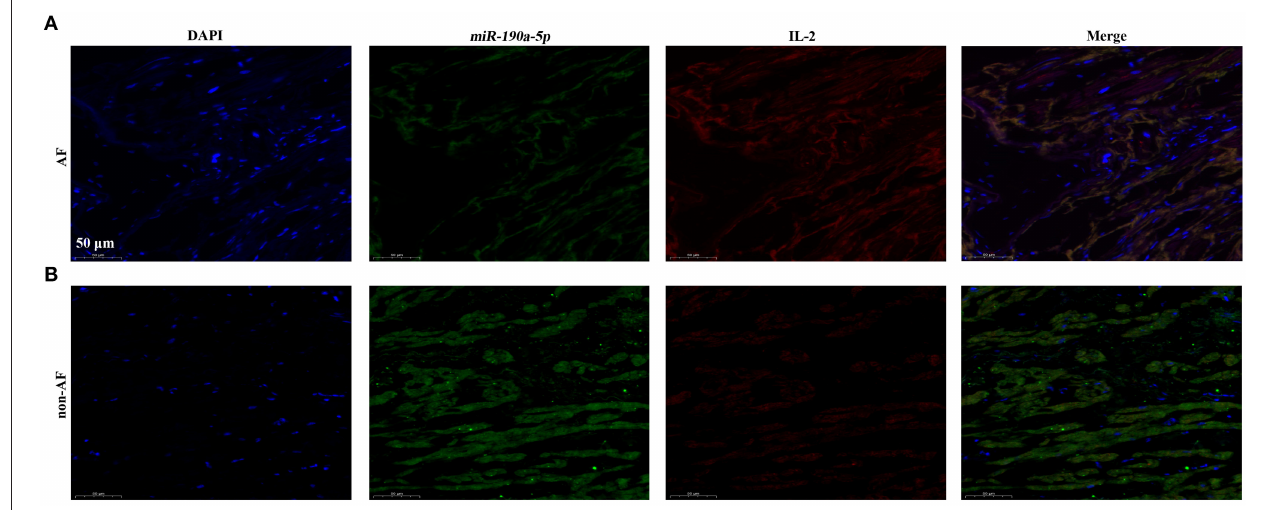
FIGURE 3 | In cardiac tissues of patients with AF, miR-190a-5p was downregulated while IL-2 was upregulated. (A) Immunofluorescence co-staining of miR-190a-5p and IL-2 in human cardiac tissues of patients with AF. (B) Immunofluorescence co-staining of miR-190a-5p and IL-2 in human cardiac tissues from non-AF control. Scale bar = 50 µ m, n = 4 per